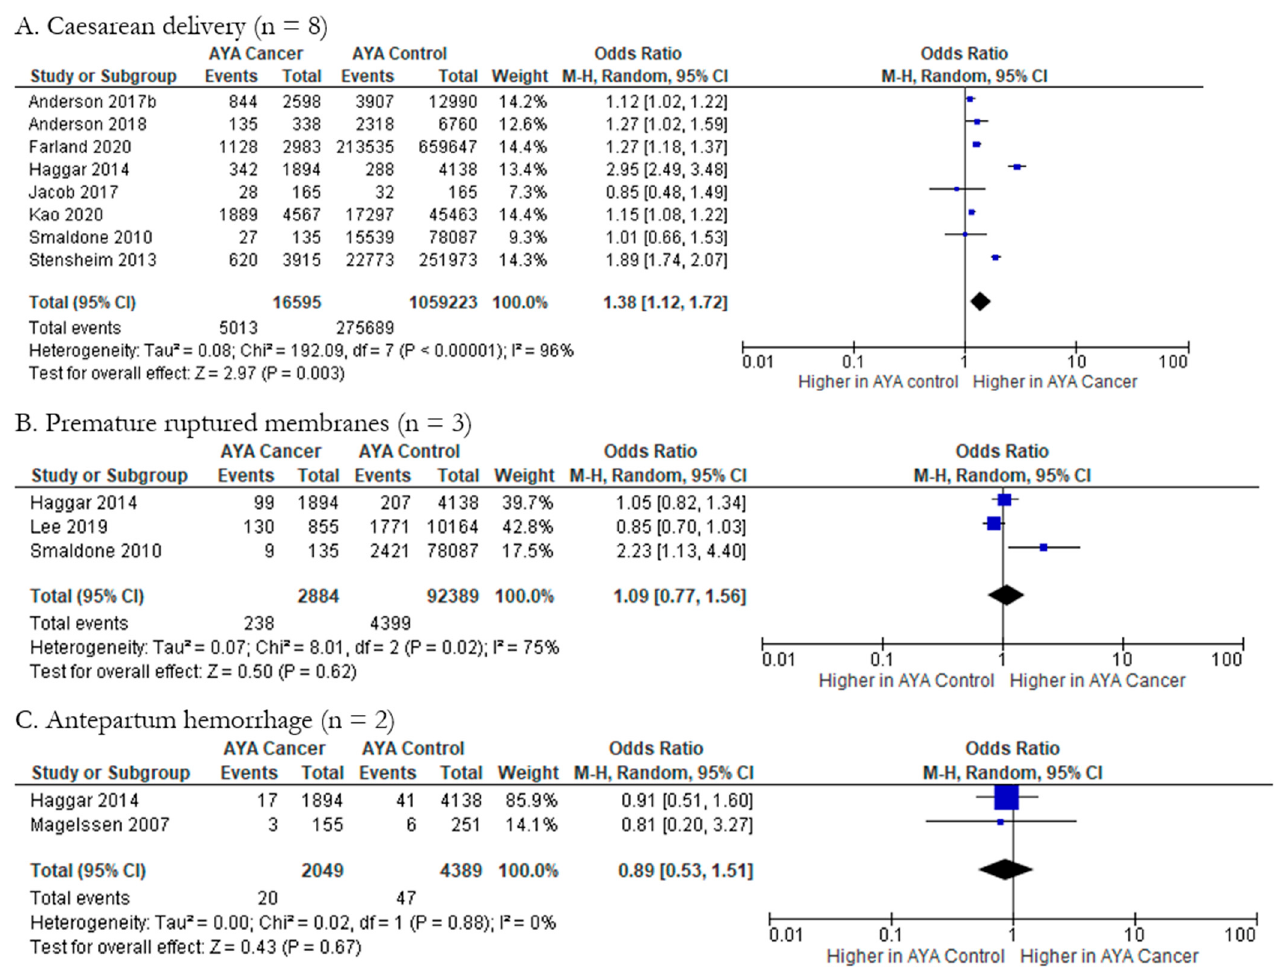
Figure 7. Forest plots for fetal/neonatal-maternal health outcomes reported by two or more studies (n = 3). A. [27,31,34,36,39,40,42,44], B. [35,36,40], C. [29,36].